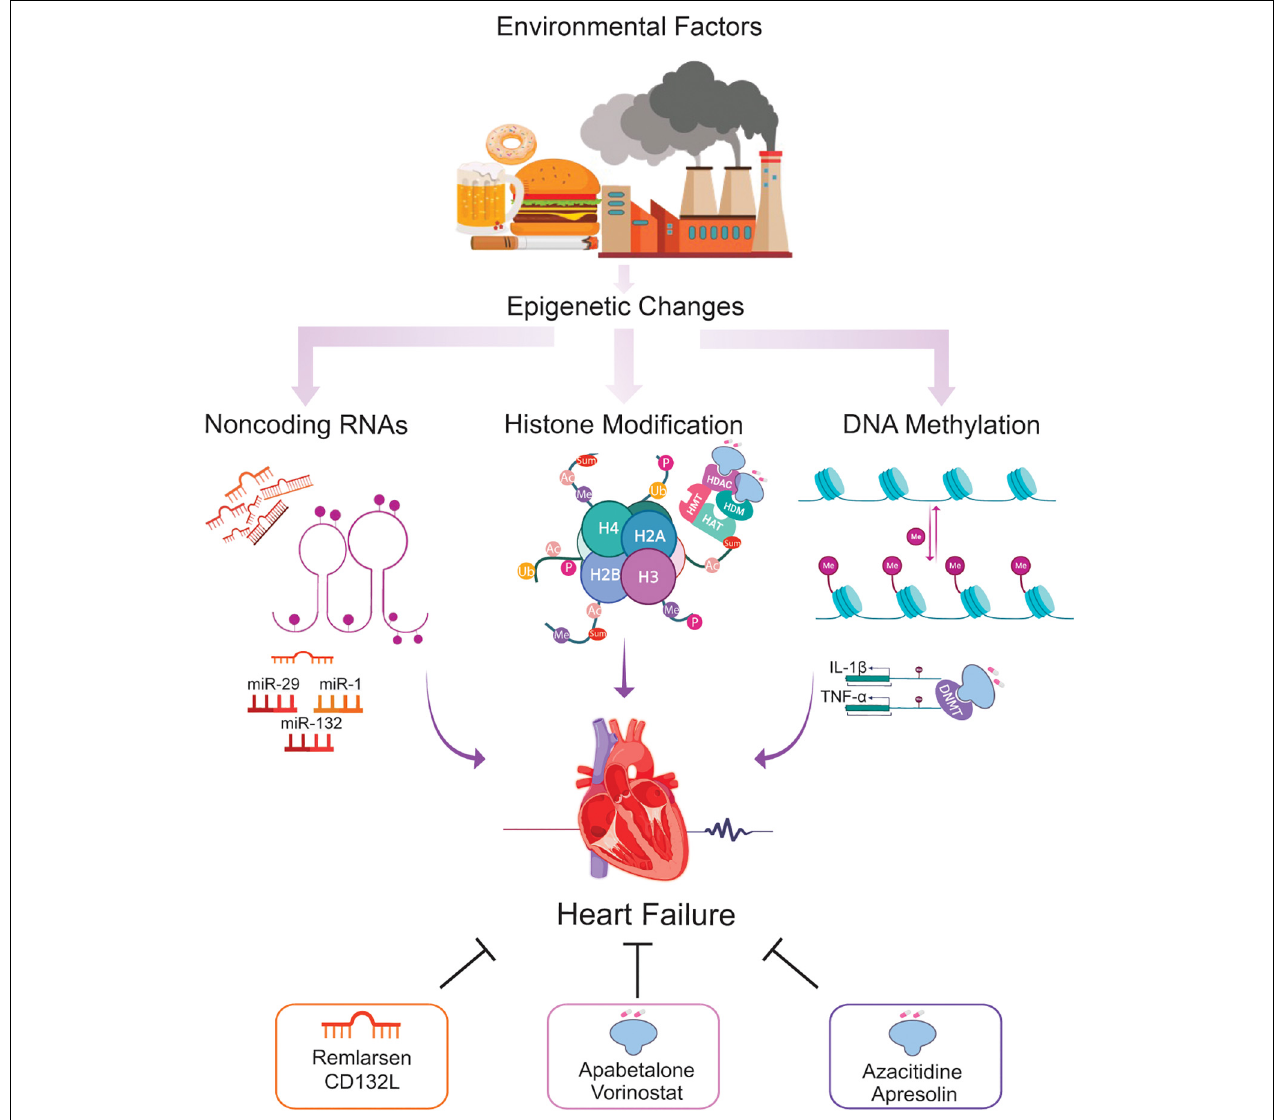
FIGURE 1 | Epigenetic changes potentially involved in the HF and the role of epi-drugs. Throughout life, numerous environmental factors induce epigenetic signals which alter the expression of genes implicated in the development of HF. Alterations in DNA methylation, histone modifications, and ncRNA elicit transcriptional changes leading to cardiac remodeling, fibrosis, and microvascular dysfunction, key hallmarks of the failing heart. Using epi-drugs to target chromatin-modifying enzymes, or employing short oligonucleotides to mimic or antagonize relevant ncRNA appear to be a promising strategy for a personalized management of patients at risk of developing HF. *Ac = acetylation, Ub = ubiquitination, Sum = sumoylation, Me = methylation, P = phosphorylation, HAT = histone acetyltransferase, HMT = histone methyltransferase, HDAC = histone deacetylase, HDM = histone demethylase, DNMT = DNA